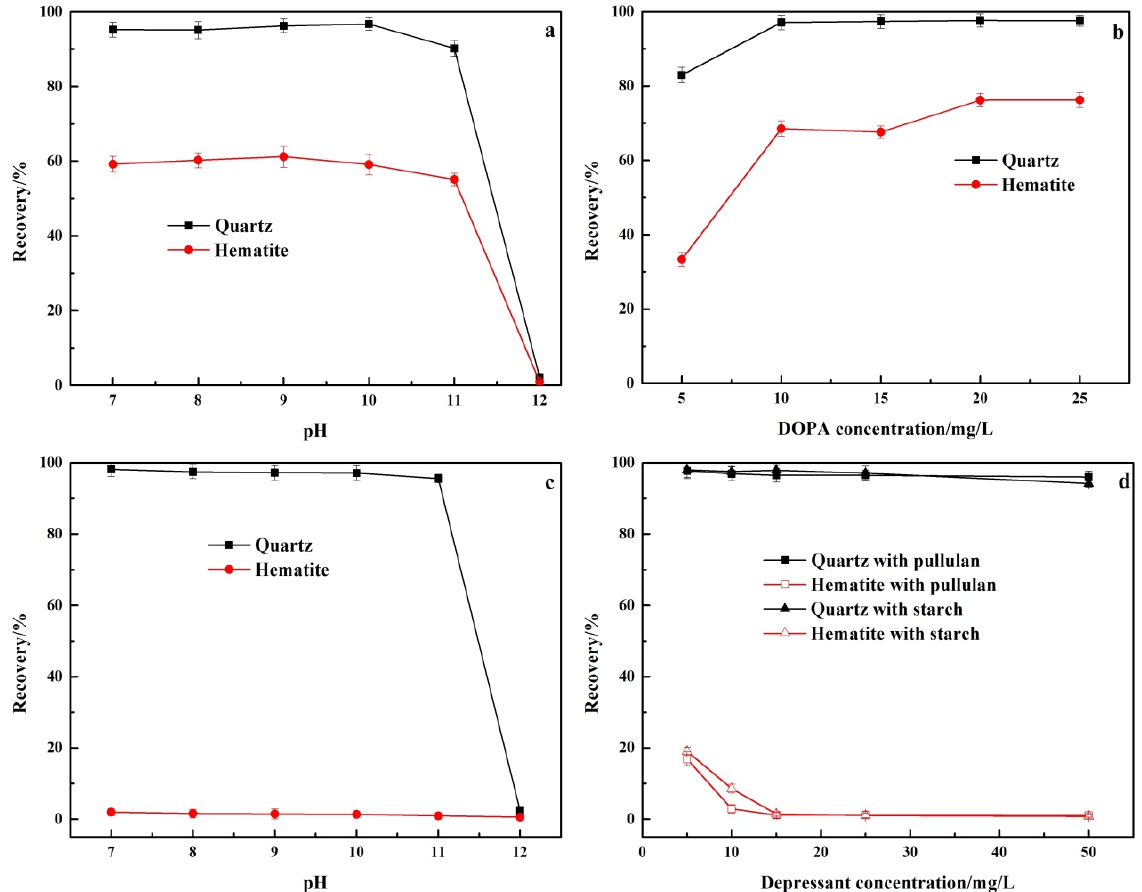
Figure 5. Effect of the addition ( a , b ) and absence ( c , d ) of pullulan and starch on the floatability of quartz and hematite. ( a ) DOPA concentration: 10 mg/L; pullulan: 0 mg/L; ( b ) pH 9, pullulan: 0 mg/L; ( c ) DOPA concentration: 10 mg/L; pullulan: 30 mg/L; ( d ) pH 9, DOPA concentration: 10 mg/L.